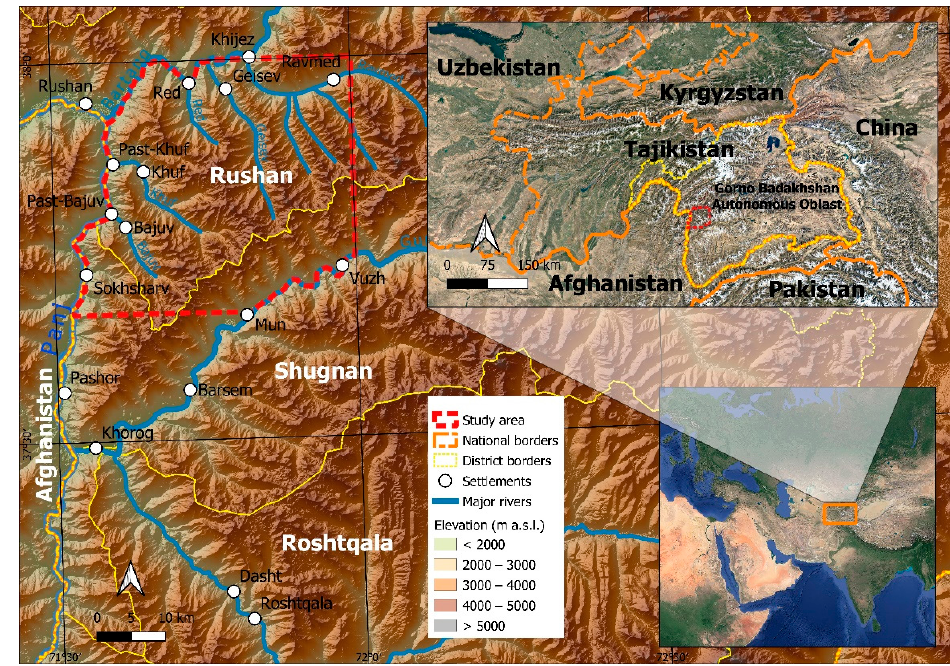
Figure 2. Overview map (source: Google Earth, SRTM [102]).